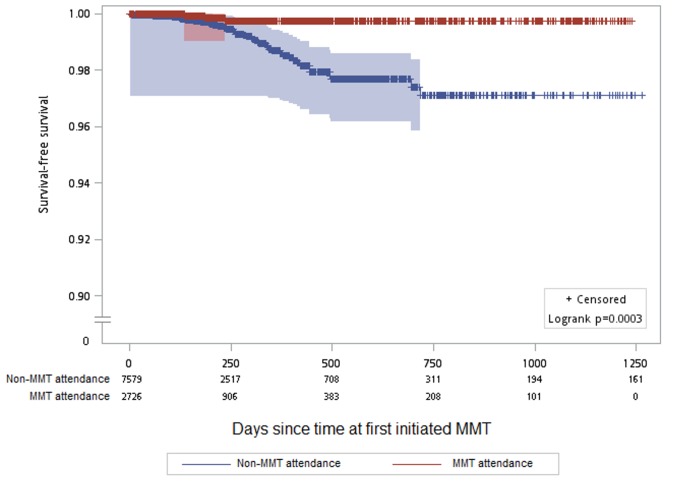
Kaplan-Meier survival estimates for HIV incidence among participants attending versus not attending MMT clinics.There were 2,473 participants followed for 12,140.1 person-years at risk on the x-axis. Gray shading indicates the 95% confidence interval. y-Axis has been interrupted to show the results in greater detail.